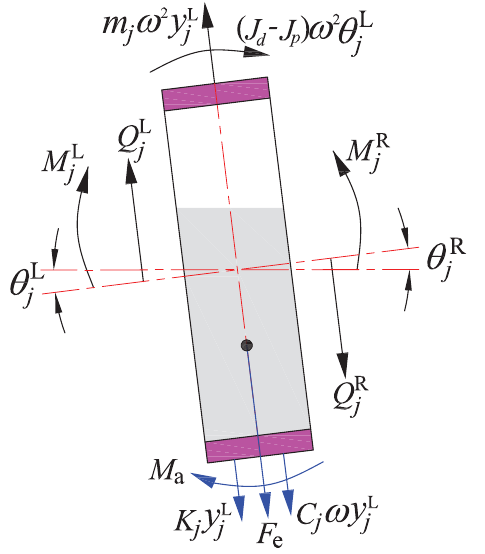
Figure 10. Mechanics analysis of tilt disk at supporting point.